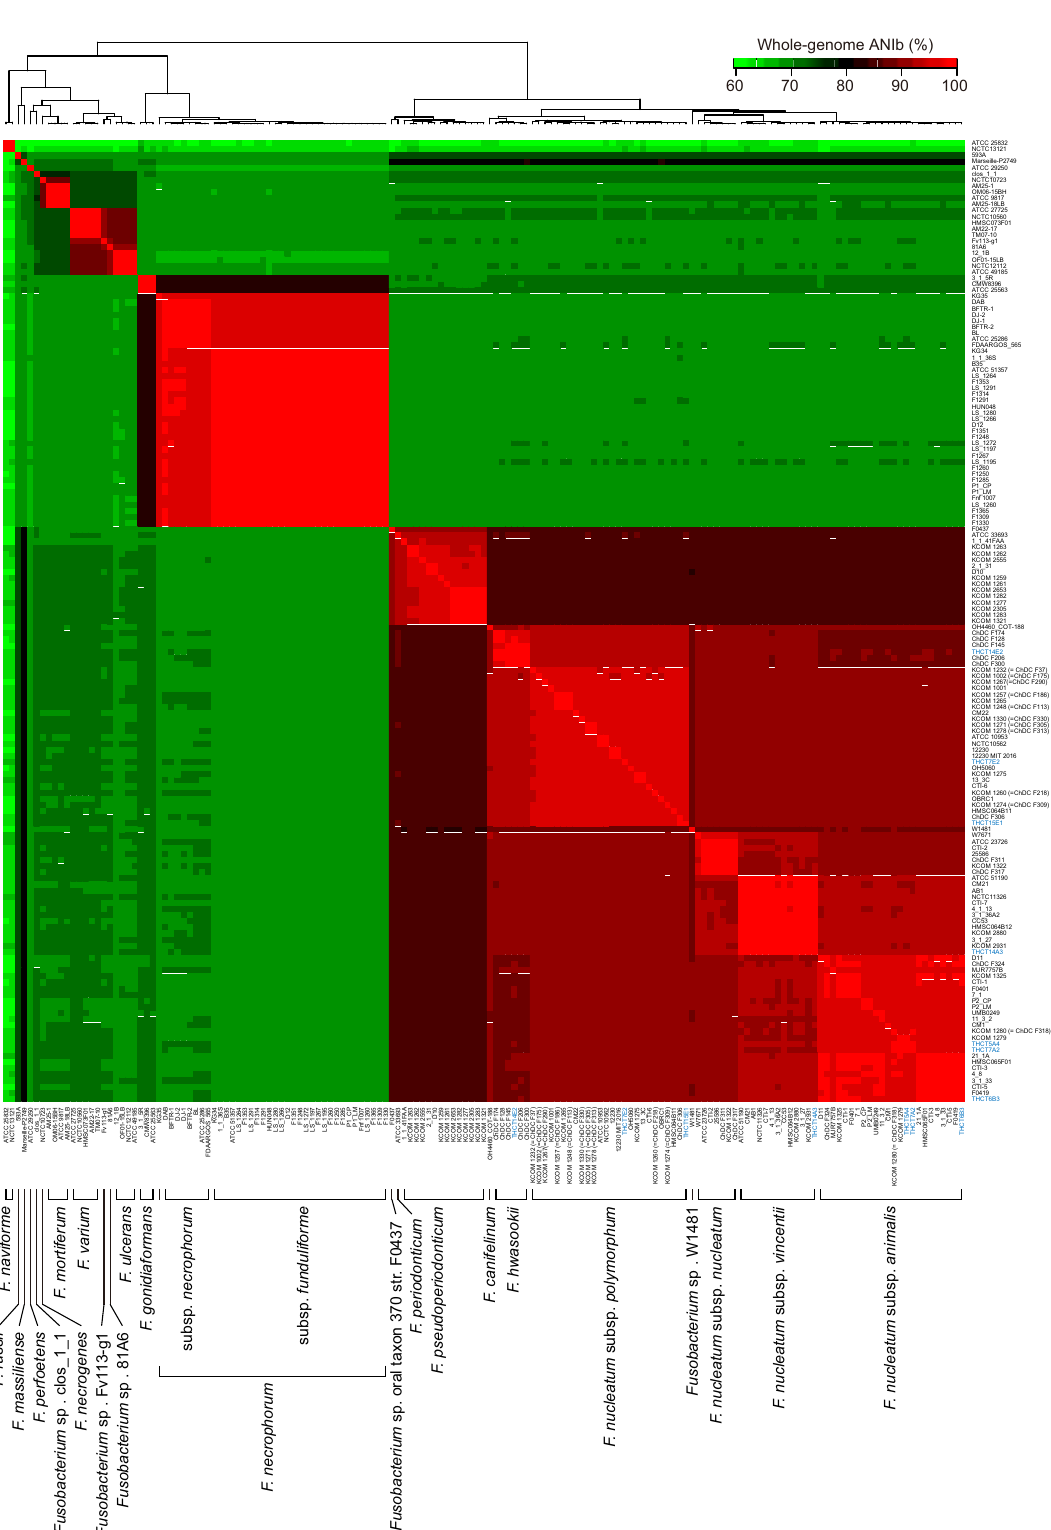
Fig. 1 Whole-genome ANIb analysis effectively de fi ned Fusobacterium species and reclassi fi ed mislabelled species annotations for genomes in the NCBI database. A total of 157 Fusobacterium genomes were used for pairwise ANIb analysis. A 157 × 157 matrix of ANIb values (Supplementary Data 2) calculated for all strains in a pairwise manner is presented as a heatmap. Strain names are listed on the right side of and under the heatmap. Blue names denote strains sequenced in this study. The resulting species/subspecies designation is shown at the bottom. ANIb, average nucleotide identity calculated with